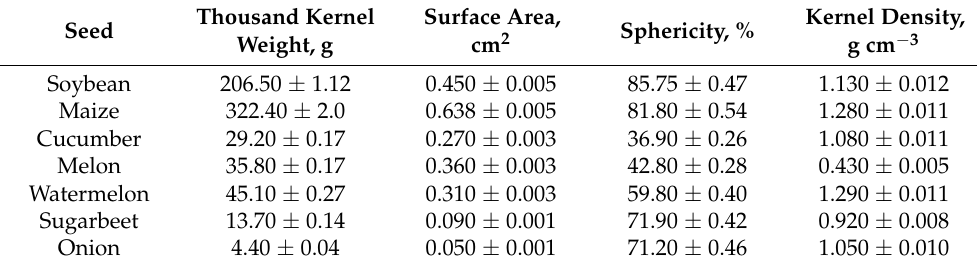
Table 4. Means and standard errors of the seed dimensions.